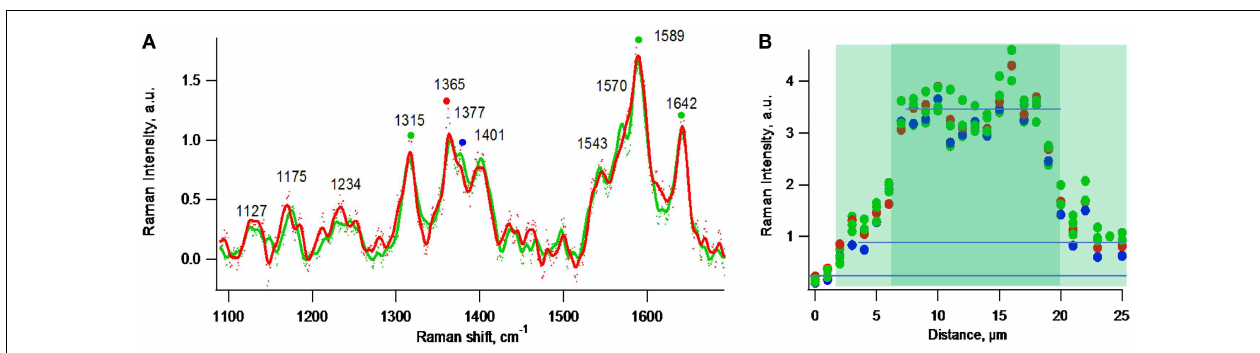
FIGURE 8 | Exponential phase biofilm . (A) Normalized at 1365cm − 1 resonance Raman spectra of representative one-cell thick region (red) and a two-cell thick region (green). (B) Intensity profile of Raman peaks marked by colored dots in (A) along the purple line indicated in Figure 6B